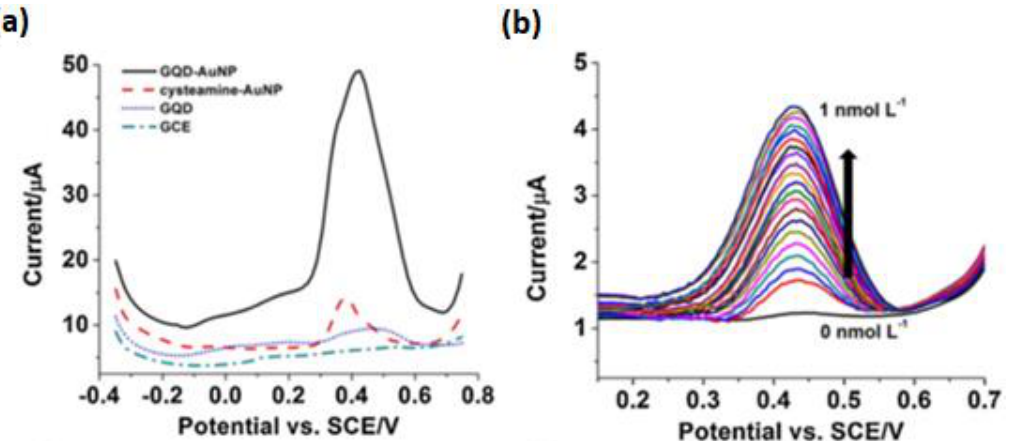
Figure 4. ( a ) Anodic stripping voltammetry (ASV) of graphene quantum dots-gold nanoparticles ( GQD-AuNP) modified with GCE in the presence of 0.1 mM of Hg 2+ ; ( b ) ASV curves of GQD-AuNP electrode with various concentrations of Hg 2+ (reproduced with permission from [102], copyright 2015 Elsevier Ltd.).